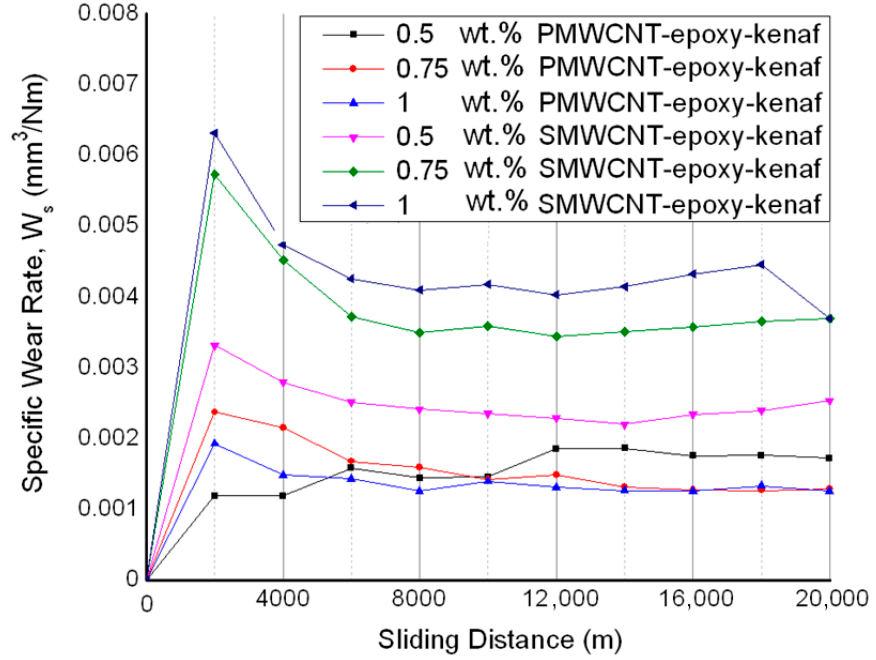
Figure 6. Specific wear rates of PMWCNT- and silane-treated MWCNT (SMWCNT)-filled epoxy– kenaf composites.